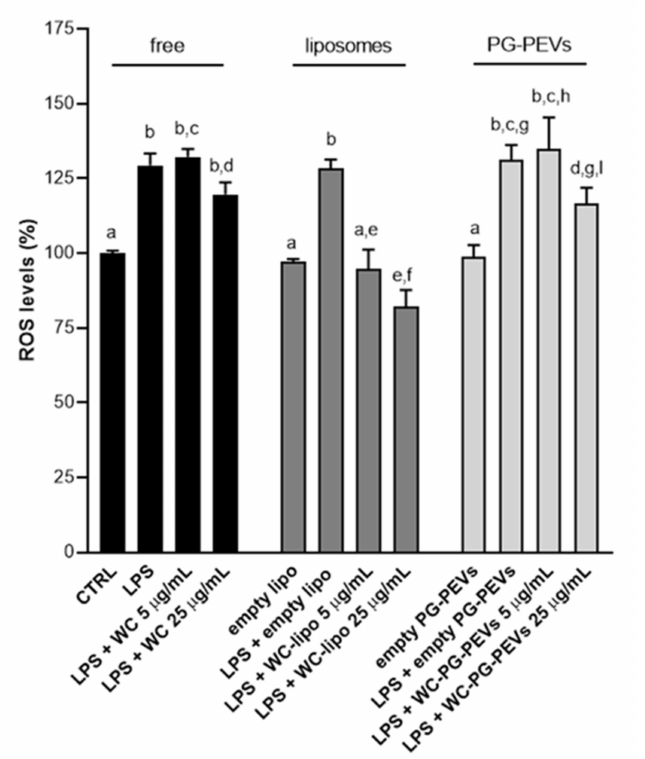
Figure 3. Effect of free WC, WC liposomes, and WC PG-PEVs on ROS production. U937/PMA cells were activated by LPS in both the presence and absence of WC, WC liposomes, and WC PG-PEVs (5 and 25 µ g/mL). After 24 h, ROS levels were quantified. Means ± S.D. of four replicate independent experiments are shown. According to one-way ANOVA, differences were significant ( p < 0.05). Thus, Tukey’s test for multiple comparisons was performed and different letters above the bars indicate significant differences between treatments at p < 0.05. Abbreviations: CTRL, untreated cells; WC, free WC; empty lipo, empty liposomes; and WC-lipo, WC